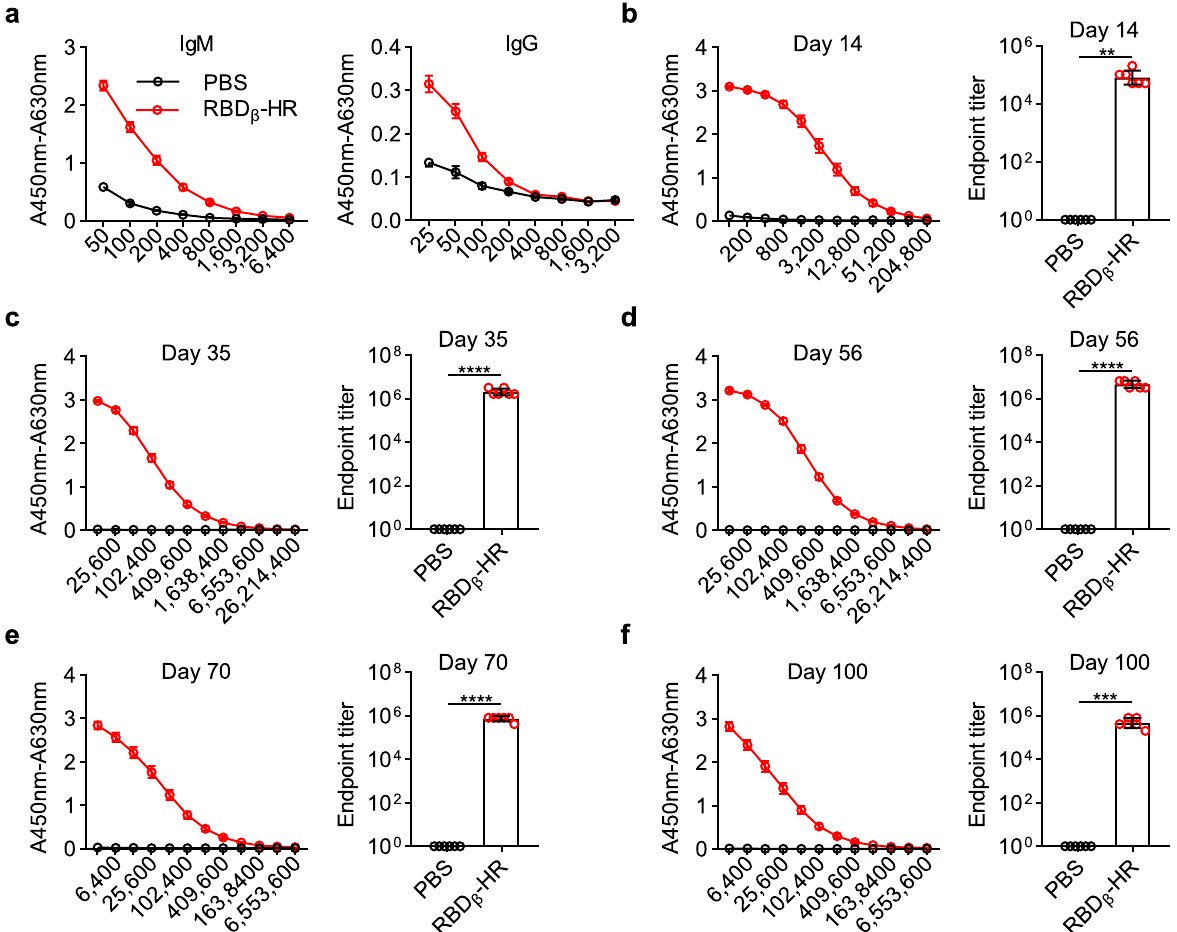
Fig. 2 RBD specific binding antibody in immunized mice. Mice were immunized with 10 μg RBD β -HR/trimer protein per mouse in 100 μL in the presence of MF59-like adjuvant with prime and booster vaccinations at an interval of 21 days, compared with the control group that received PBS with a volume of 100 μL. a Sera were obtained from the mice 7 days after the prime vaccination and the levels of IgG and IgM against RBD protein were detected at a serial of serum dilutions. b‑f The levels of IgG at a serial of serum dilutions (left) and the endpoint titers (right) of the sera obtained on day 14 ( b ), 35 ( c ), 56 ( d ), 70 ( e ), 100 ( f ) after the prime vaccination. The absorbance at 450 nm was measured using a microplate reader with the wavelength correction set to 630 nm. Data are geometric mean SD. p value < 0.05 were considered statistically significant (* p < 0.05; ± ** p < 0.01; *** p < 0.001; **** p <